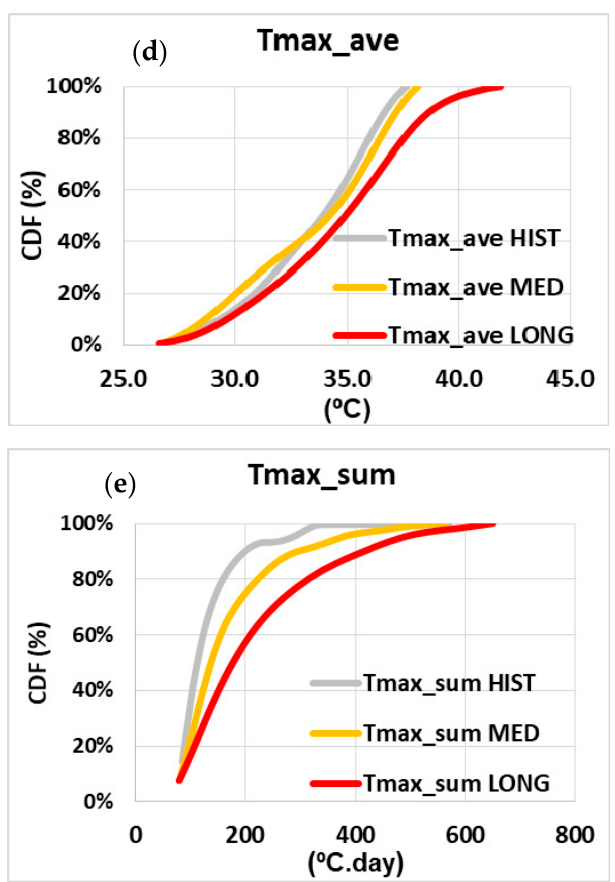
Figure 15. CDF of ( a ) DUR, ( b ) INT, ( c ) RF, ( d ) Tmax_ave and ( e ) Tmax_sum for HIST, MED, and LONG. There is a marked shift of percentiles toward higher values from HIST to MED and